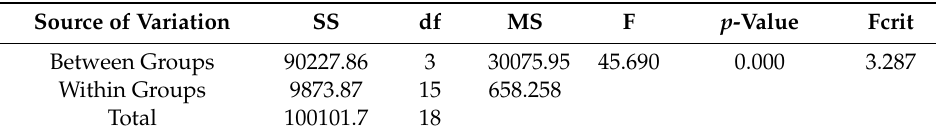
Table 3. ANOVA of tensile modulus and b. post hoc